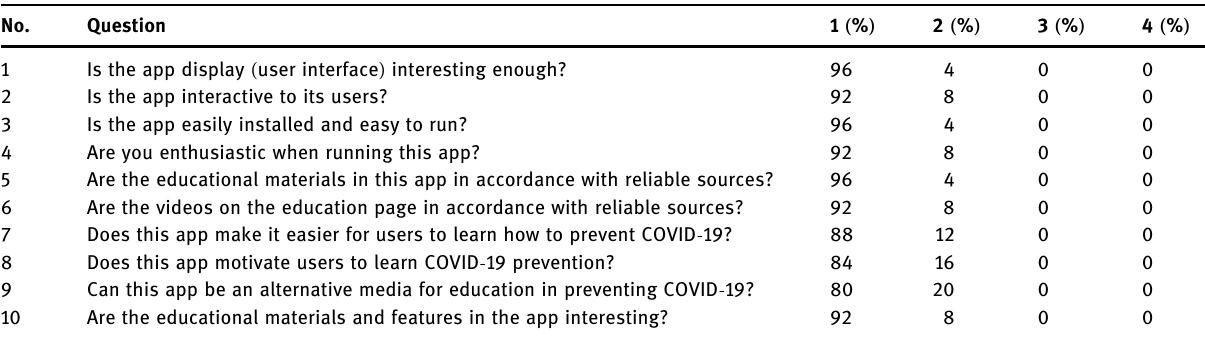
Table 5: Results of the user acceptance